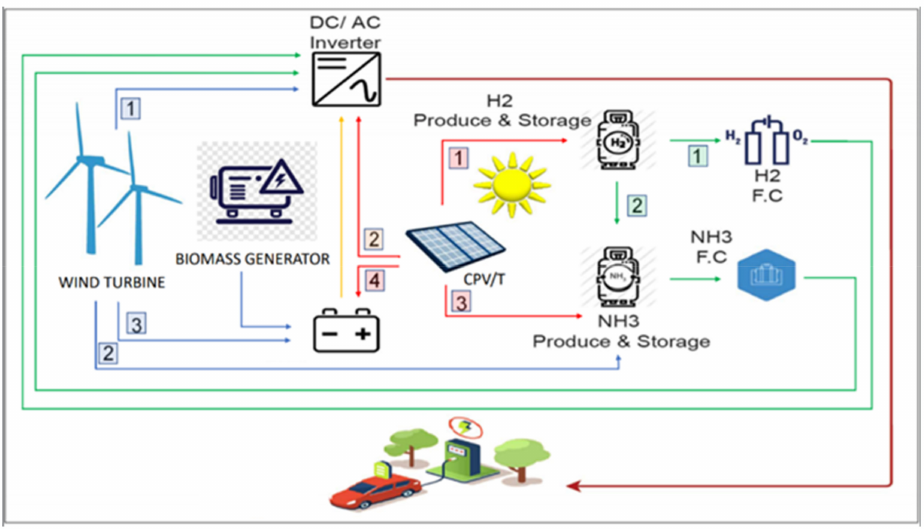
Figure 1. Stand-alone fast charging station schematic